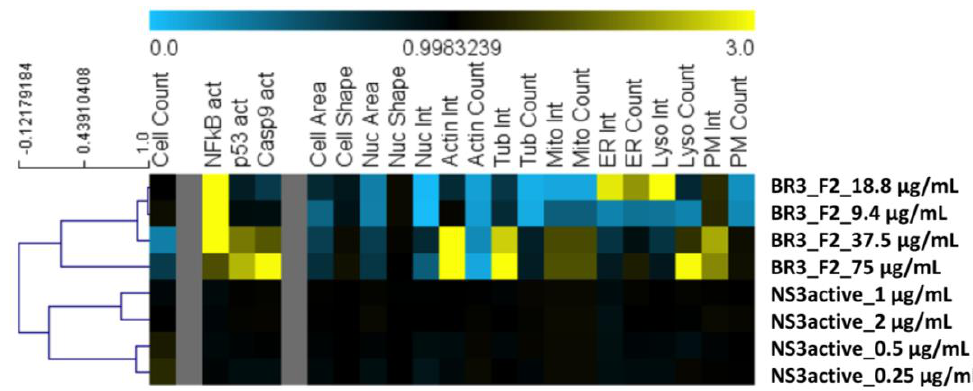
Figure 5. Cytolological profiles composed of 21 core features of the two parent fraction dilutions and dilutions of compound 1 . Colors indicate positive (yellow) or negative (blue) deviation from the mean of untreated control cells (value = 1). Full cytological profiles were used for clustering (left). The dendrogram depicts distances between individual cytological profiles based on Pearson correlation with average linkage for four dilutions of the parent SPE fraction (BR3_SPEfraction2_concentration) and four dilutions of the NS3 active fraction isolating compound 1 (NS3acitve_concentraion).